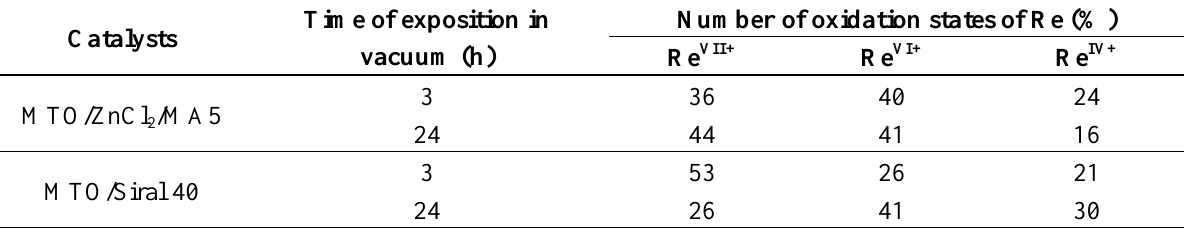
Table 5. Characterization results of the oxidation states of Re in MTO supported catalysts by X-ray photoelectron spectroscopy (5 mg MTO/100 mg